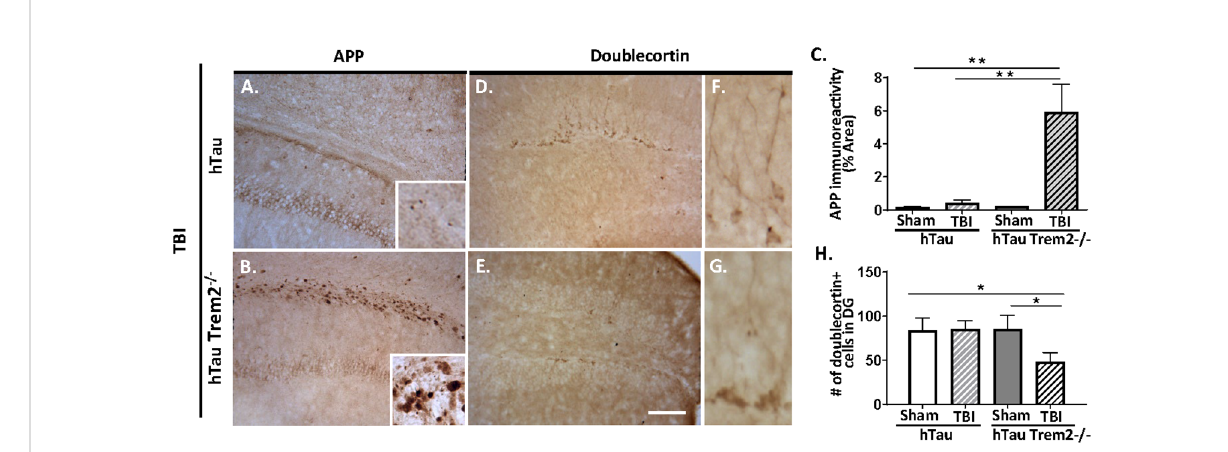
FIGURE 3 The axonal injury was accelerated in the white matter, and neurogenesis was impaired in injured hTau; Trem2 -/- mice at 120 DPI. (A, B) Representative images of APP immunostaining in hTau TBI and hTau; Trem2 -/- TBI mice in the external capsule near the lesion site. (C) Quanti fi cation of percent area covered by APP. (D, E) Representative images of doublecortin immunostaining in hTau TBI and hTau; Trem2 -/- TBI mice in the hippocampus. (F, G) Magni fi ed view of (D, E) . (H) Quanti fi cation of the number of doublecortin positive cells identi fi ed impaired neurogenesis in hTau; Trem2 -/- TBI mice. All experiments used n = 6 (equal males and females) mice per group unless otherwise noted. At least two independent experiments were performed for each analysis. The scale bar represents 50 m m. Error bars indicate SEM; * p <0.05, ** p